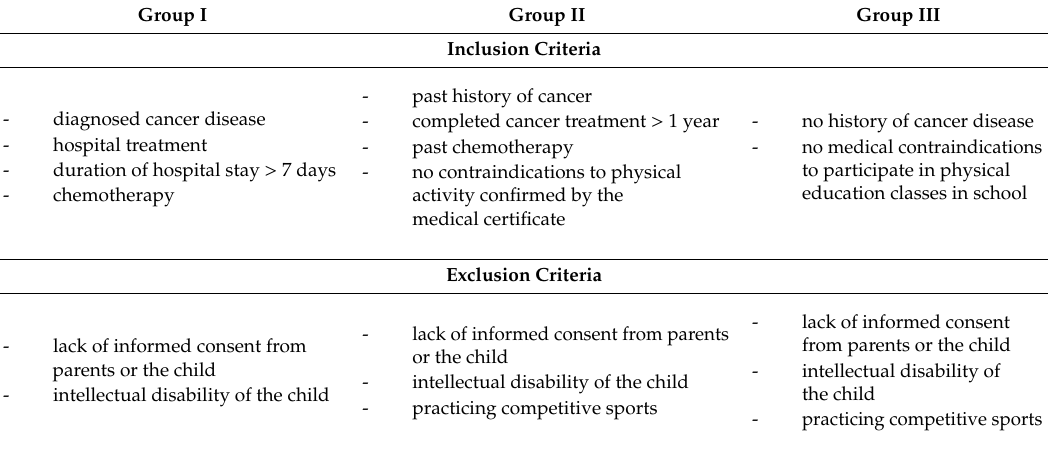
Table 2. Inclusion and exclusion criteria in the study